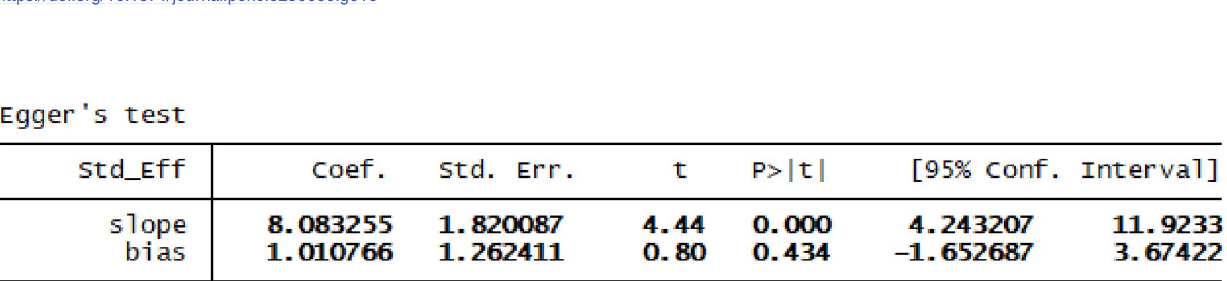
Fig 11. Publication bias on the magnitude of atrial septal defect among congenital heart defect patients in East Africa from January 2000-October, 2020.